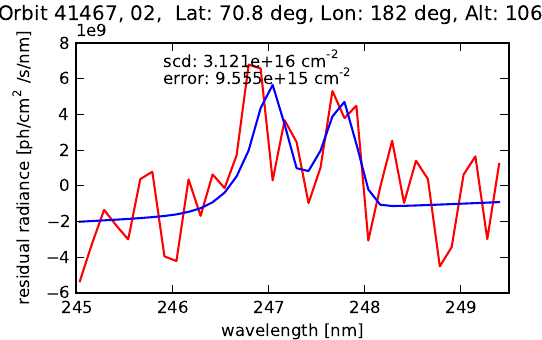
Fig. 2. NO (0,2) spectral fit, showing the residual spectra (red) after dark-current subtraction and Rayleigh background fit, and the fitted NO spectrum (blue) with a low order polynomial as a baseline.